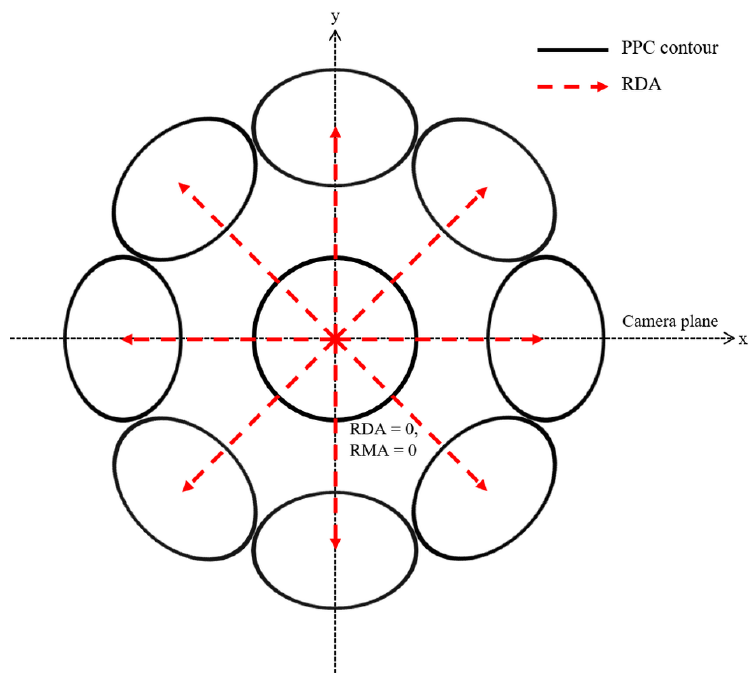
Figure 1. Conceptual diagram of an ideal PPC according to RDA changes.